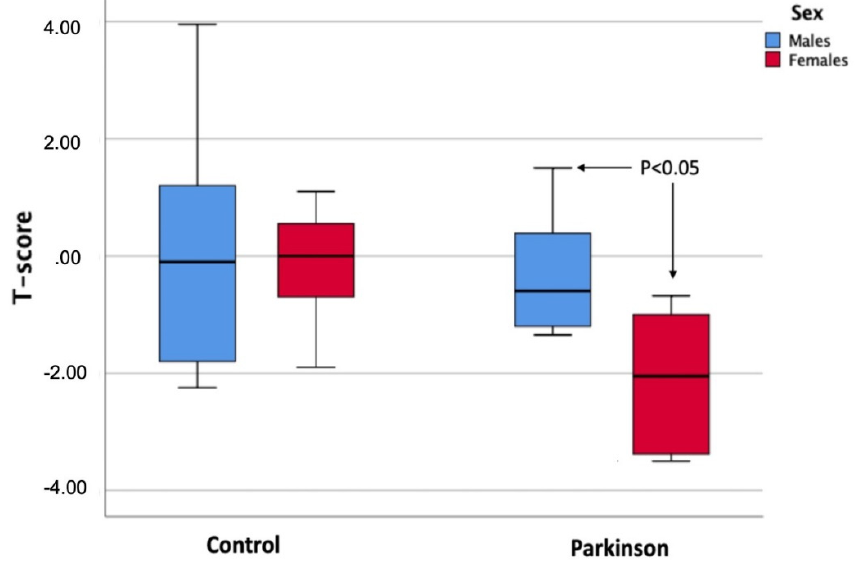
Figure 1. Comparison of T-score values between both sexes in each of the study groups (control group and Parkinson’s group).